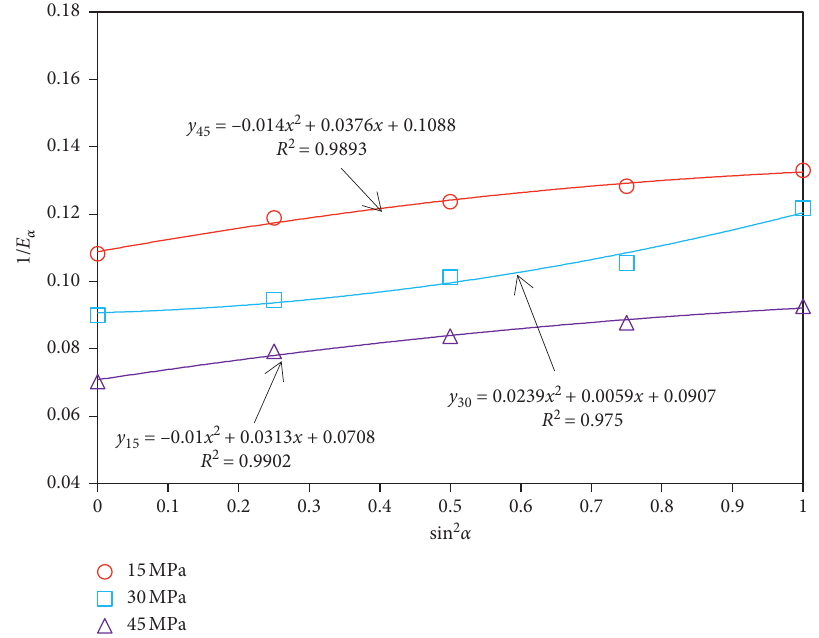
2 under different confining pressures. α ) versus sin α